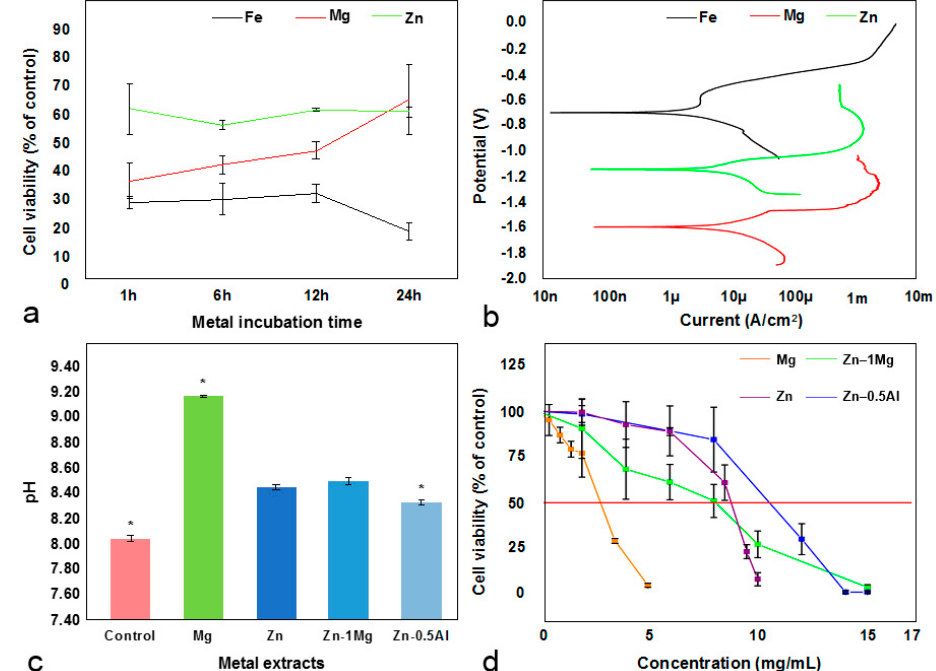
Figure 2. Screening test results: ( a ) viability of urothelial cells as a function of the metal incubation time in artificial urine solution, ( b ) potentiodynamic polarization curves of pure iron, magnesium, and zinc (potential in Volt (V) vs. saturated calomel electrode (SCE)), ( c ) pH value of metal extracts in urothelial basal medium, *p < 0.01, ( d ) viability of urothelial cells treated with different concentrations of metal extracts. Red line marks 50% of cell viability.